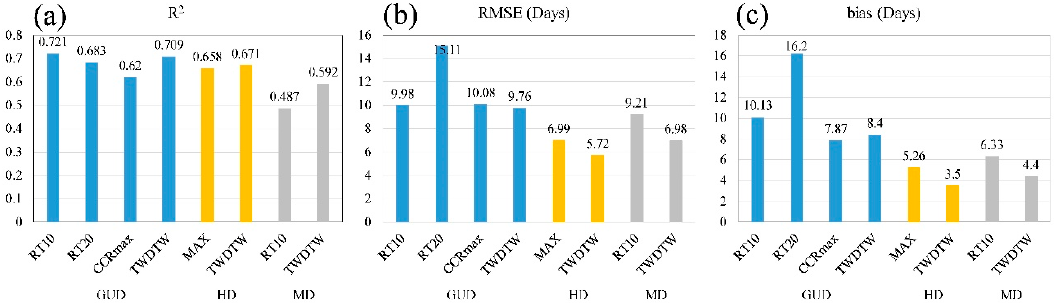
Figure 14. Comparisons between the TWDTW method and other methods on ( a ) R 2 , ( b ) RMSE, and ( c ) bias.